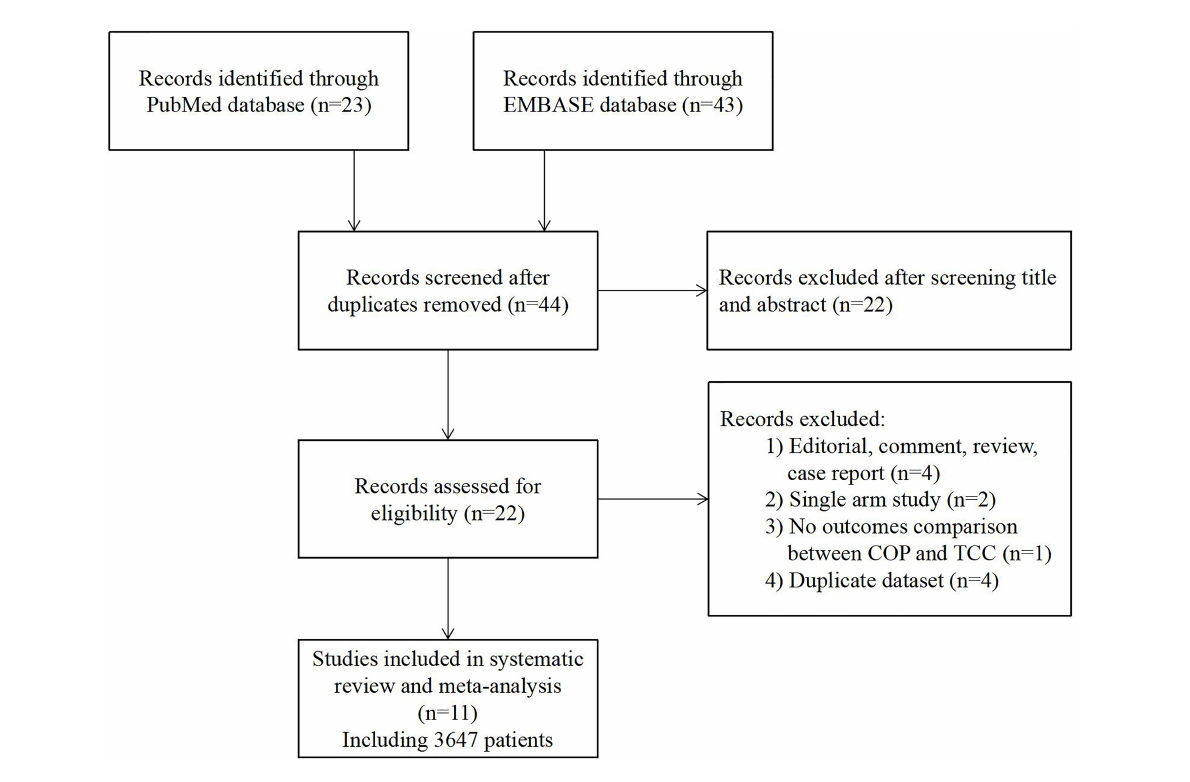
FIGURE2 Flow diagram. COP, cusp-overlap projection; TCC, three-cusp